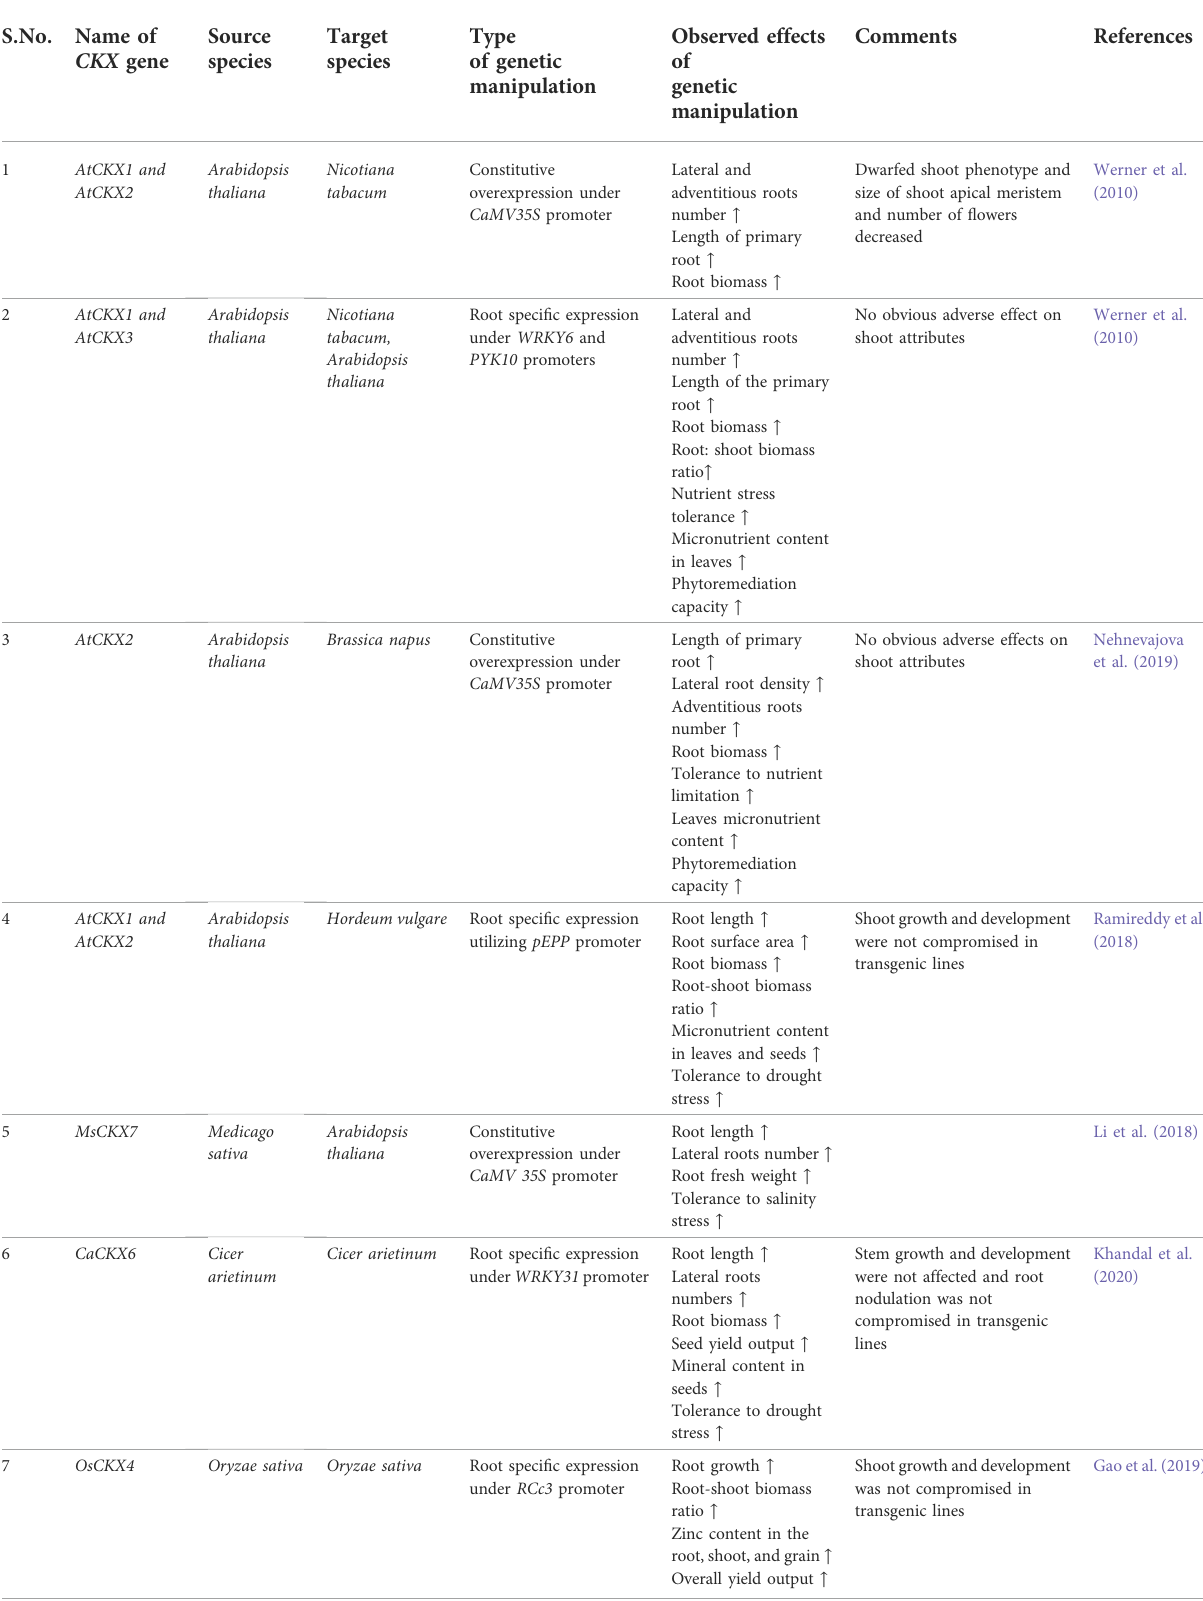
TABLE 3 Genetic manipulation of CKX genes for drought tolerance and enhanced micronutrient